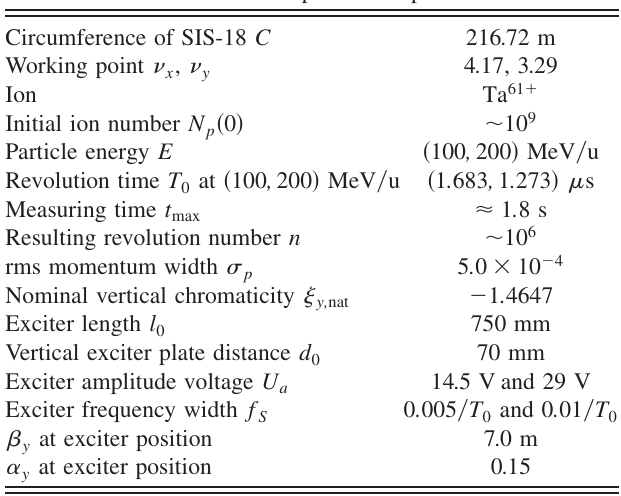
TABLE I. Main experimental